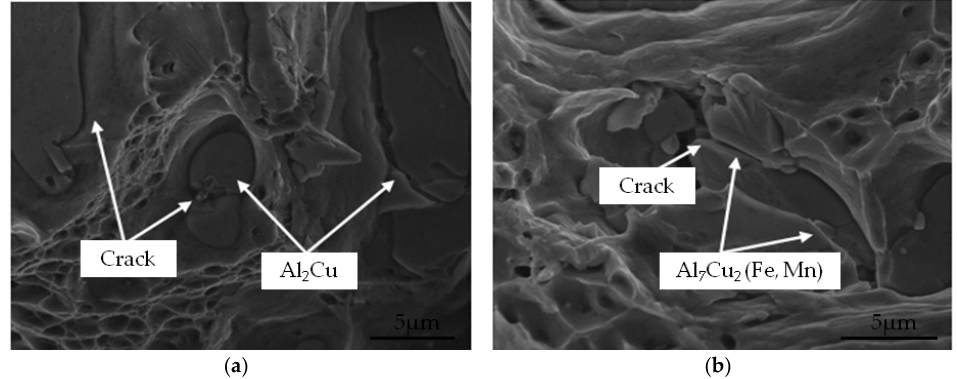
Figure 13. SEM morphology of residual constituents and cracks on fracture surfaces of 2219 aluminum alloy: ( a ) Cracks on Al 2 Cu phase and coarse particles/Al matrix interfaces; ( b ) cracks appearing along Al 7 Cu 2 (Fe, Mn) phase.